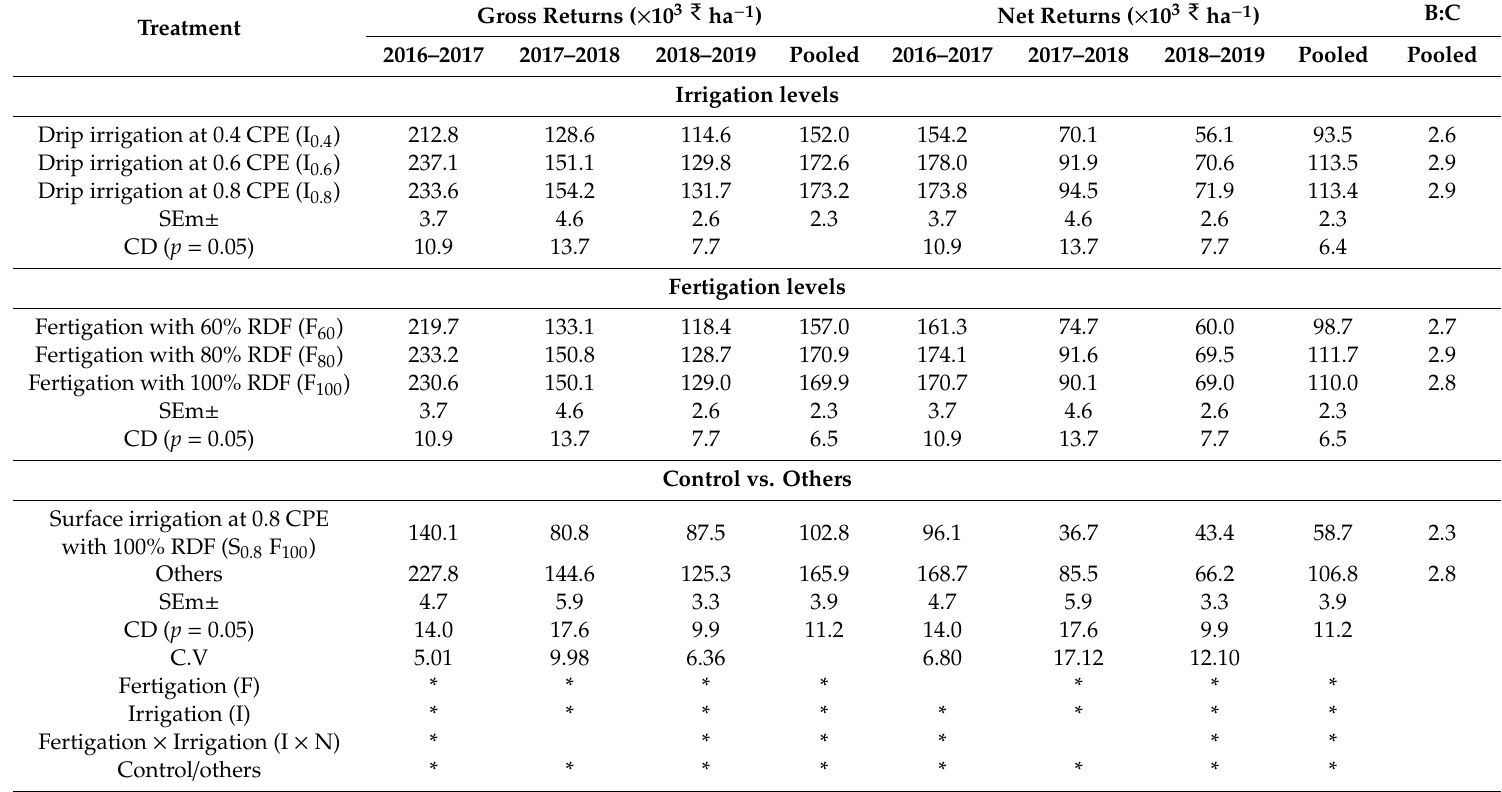
Table 3. Economics of drip irrigation and fertigation levels in cumin (pooled data of three years). (31.4 cm), umbels plant − 1 (50.4), umbellates umbel − 1 (5.07), seeds umbel − 1 (5.34), test weight (4.60 g), Gross Returns ( × 10 3 Treatment cost ratio (2.9) over drip fertigation at 0.4 CPE and surface irrigation with 0.8 CPE. The fertigation with 80% recommended dose of fertilizer (RDF) being at par with 100% RDF recorded a significantly